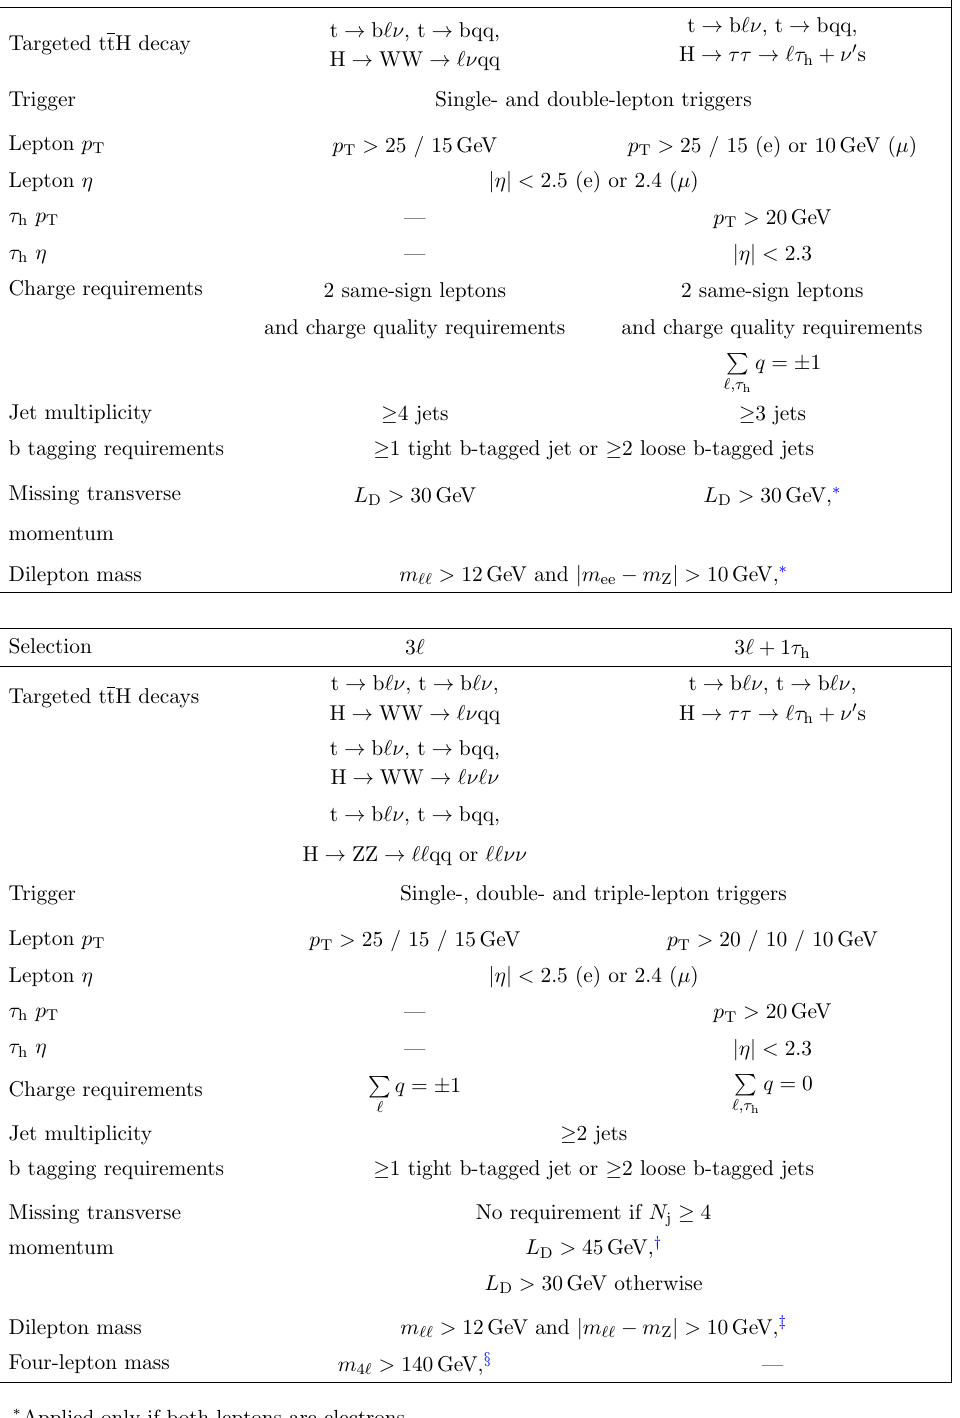
Table 1 . Event selections applied in the 2 ‘ ss, 2 ‘ ss + 1 (cid:28) h , 3 ‘ , and 3 ‘ + 1 (cid:28) h categories.